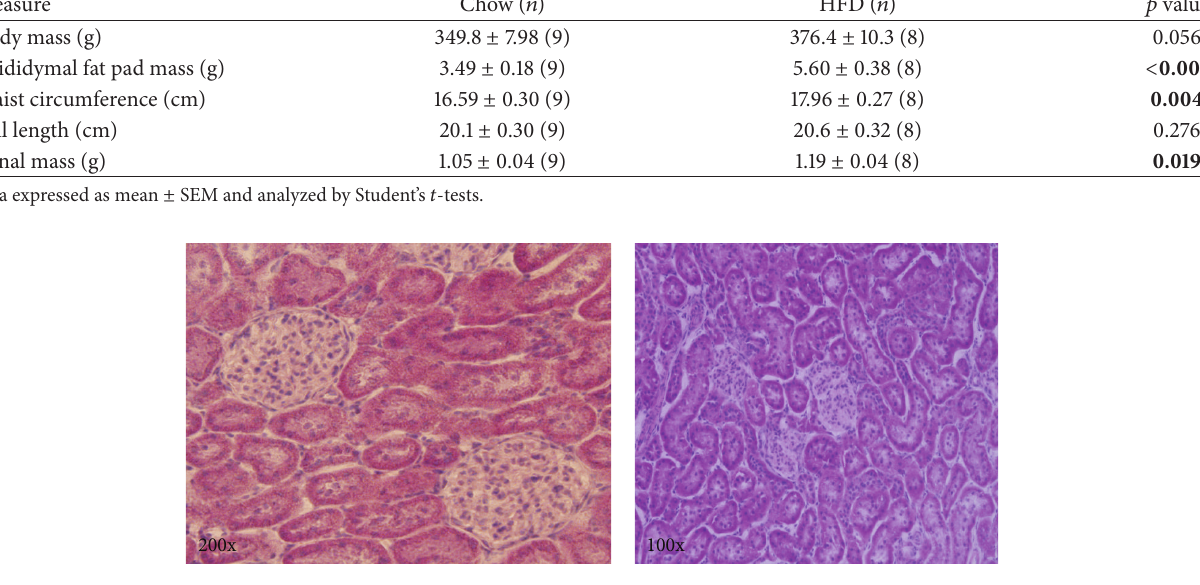
Figure 1: Representative images of hematoxylin and eosin stained renal tissue sections from HFD animals. Hematoxylin and eosin staining shows no signs of morphological